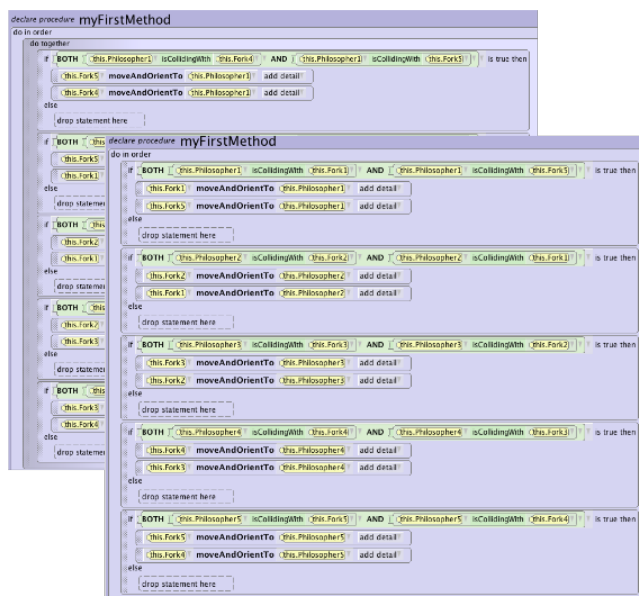
Fig. 5 Alice and the use of do in order and do